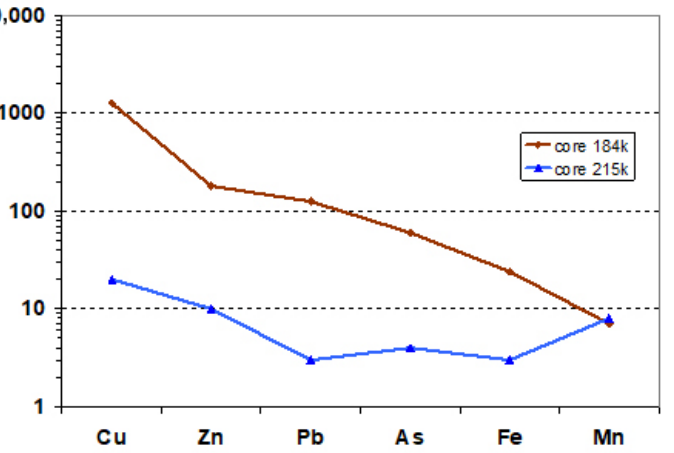
Figure 3. Comparison of the enrichment factor (EF) of some heavy metals and As in the ore- bearing 184k and background 215k cores.